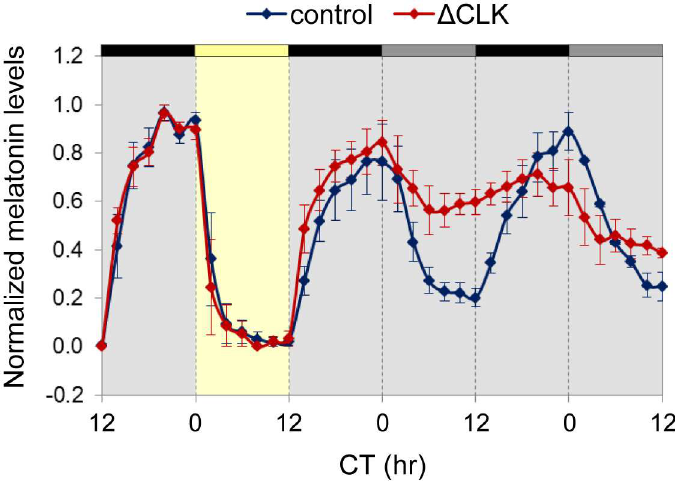
Fig 3. Clock-controlled rhythms of melatonin production are disturbed in Δ CLK-expressing pineal glands. Circadianrhythms of melatoninrelease from cultured pinealglandsof Tg( aanat2 :EGFP- Δ CLK) adult fish are disturbedunder DD ( p < 0.05,Kolmogorov-Smirnov test). Yellow bar representsthe light period, black bars represent dark, and gray bars represent dark duringsubjectiveday. Values indicatethe normalized amount of melatoninproducedby the glands. Error bars represent SE ( n = 3). CT,